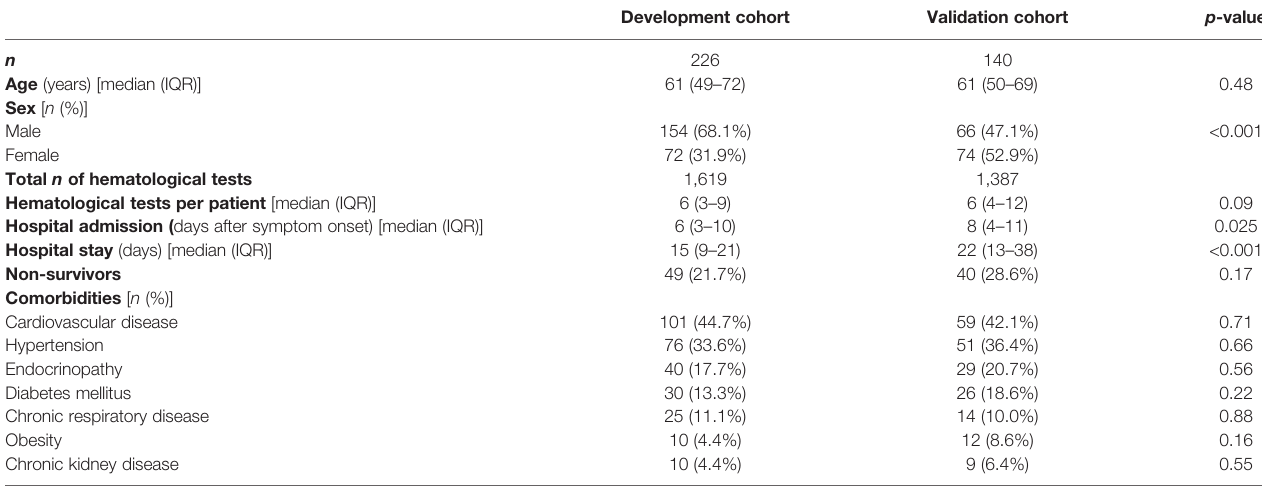
TABLE 1 | Baseline characteristics of the evaluated